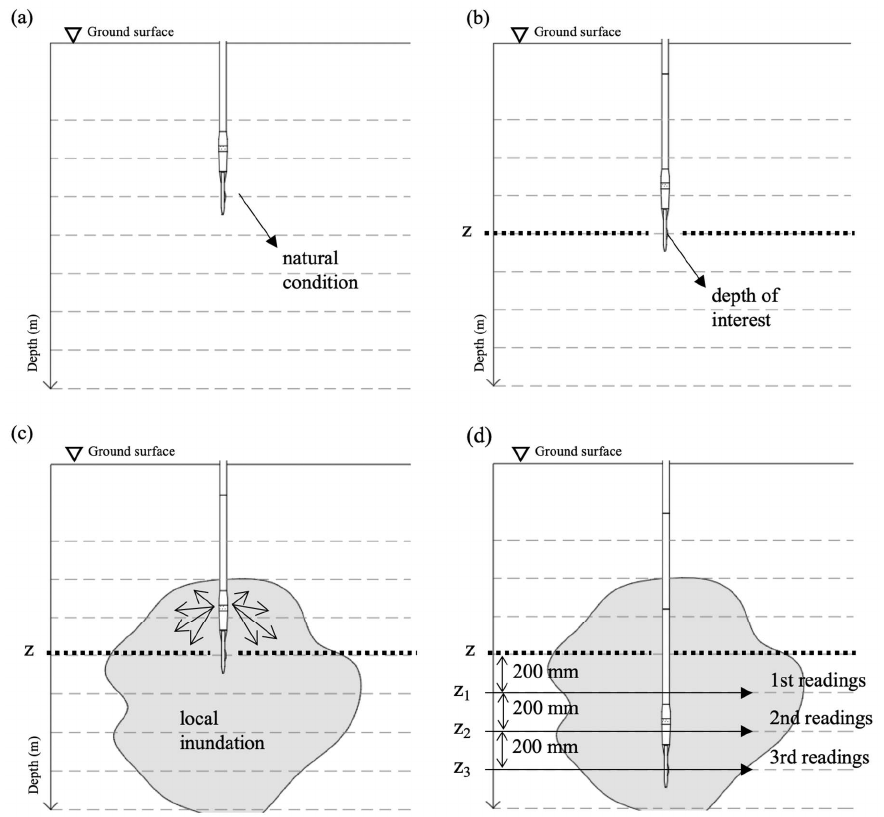
Figure 3. Schematic representation of DMT inundation process, ( a ) test under natural condition, ( b ) depth of interest; ( c ) local inundation and ( d ) readings under inundated condition. Adapted from [32].